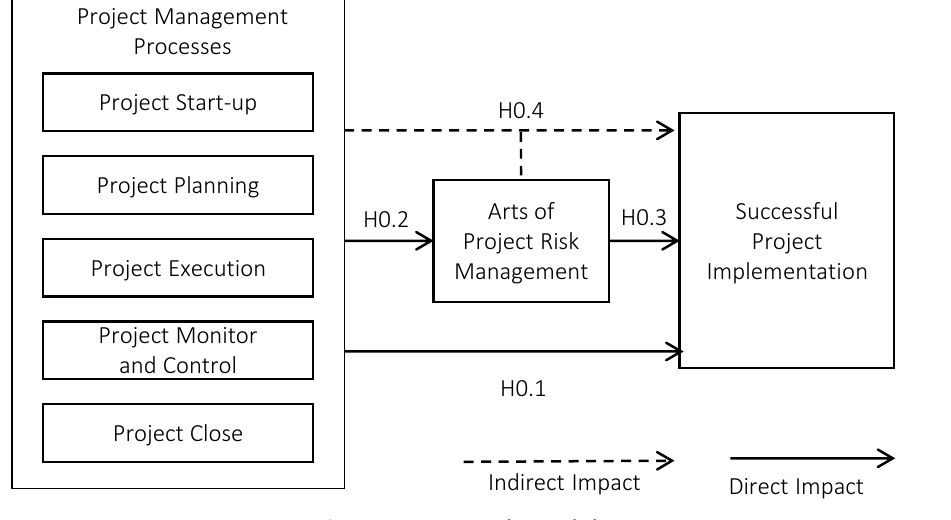
Figure 1. Research Table 1. Demographic information